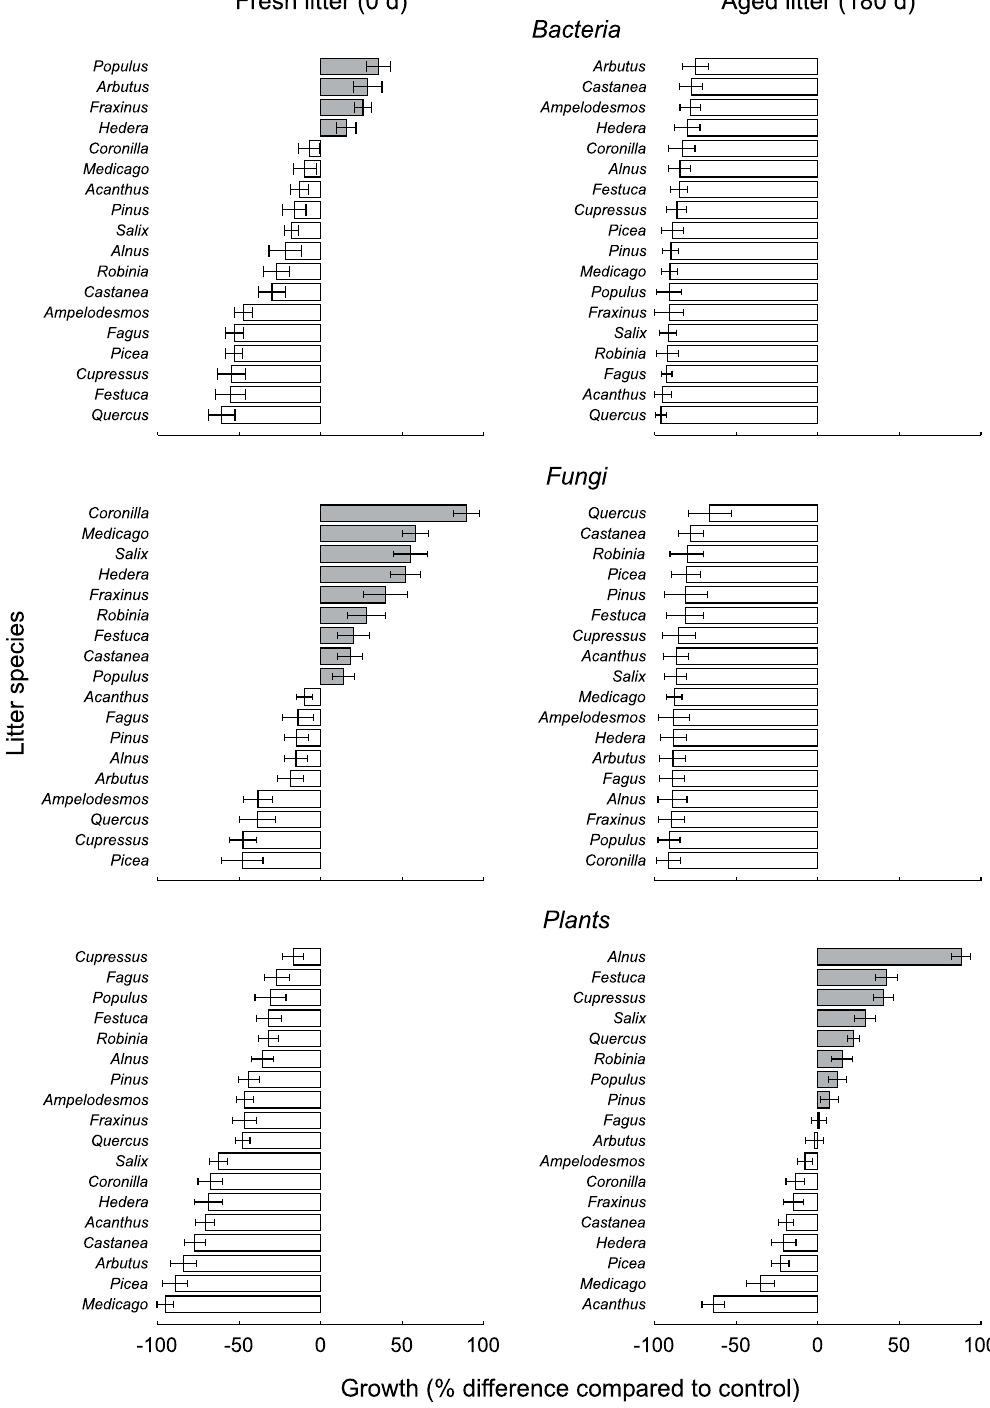
Figure 1. Effects of 18 different litter materials, either undecomposed (left) or after 180 days of decomposition (right), on the growth of selected bacteria (top) and fungi (center) and higher plants (bottom). Growth is expressed as percent difference compared to the controls (Nutrient Broth, and PDA and water for bacteria, fungi and plants, respectively). White and gray bars indicate inhibitory and stimulatory effects, respectively. For each bar, data refer to mean ± standard error of 14, 6 and 6 target species for plants, bacteria and fungi,